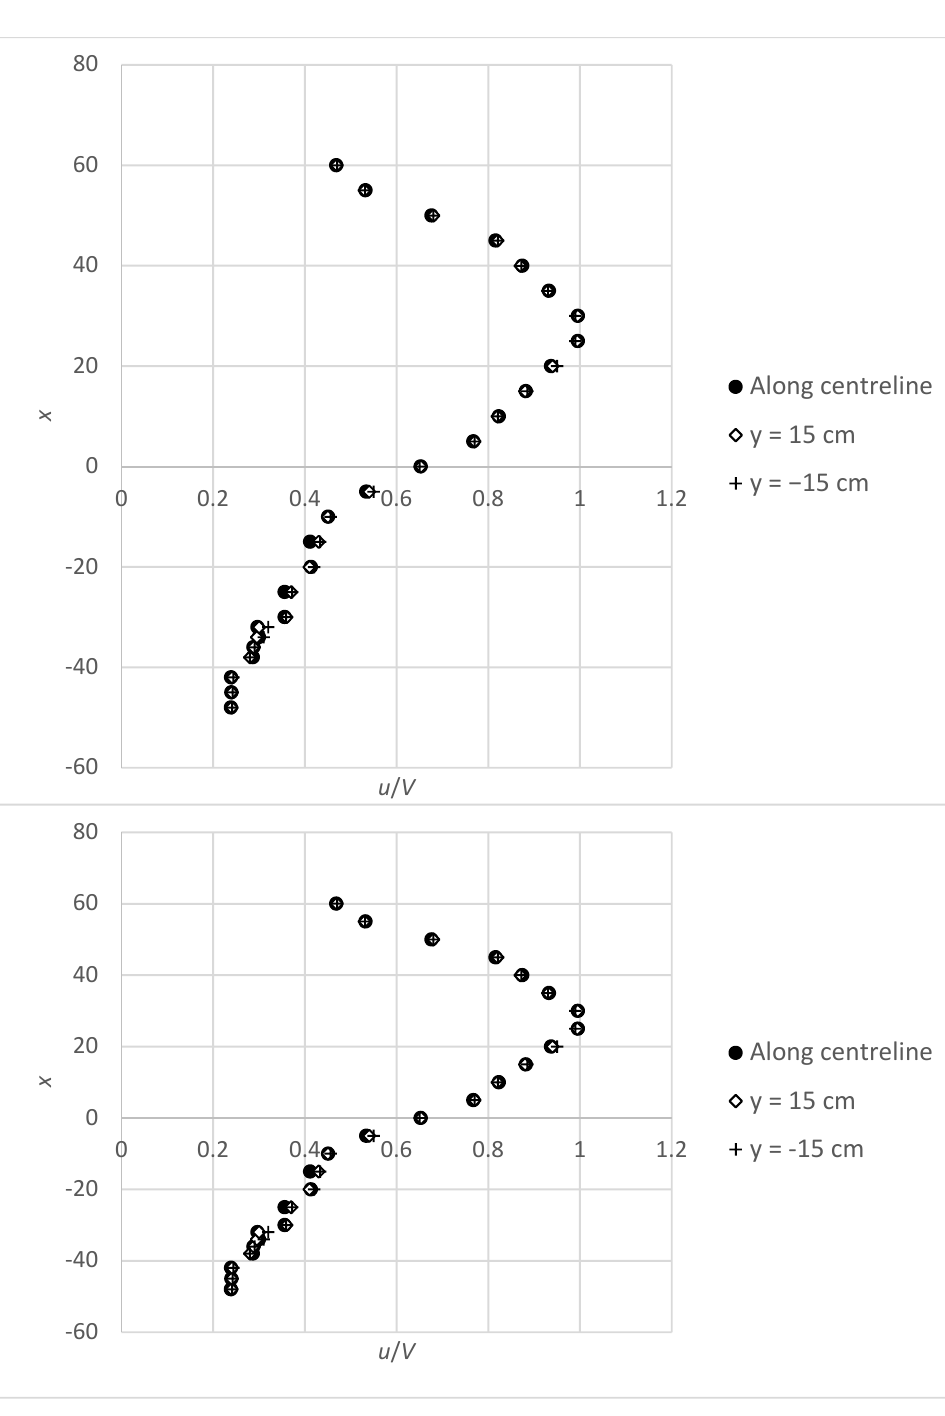
Figure 3. Velocity profiles at different longitudinal sections within the scour hole.